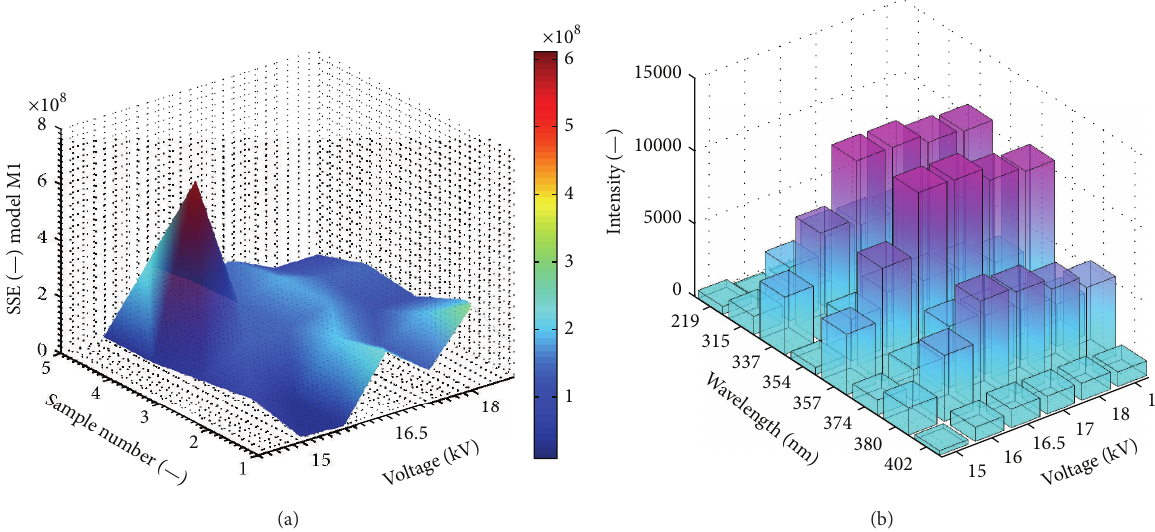
Figure 9: (a) Voltage dependency on SSE obtained by model M1 for all data samples. (b) Intensity of wavelength components obtained by model M1 as a function of PD generation voltage.